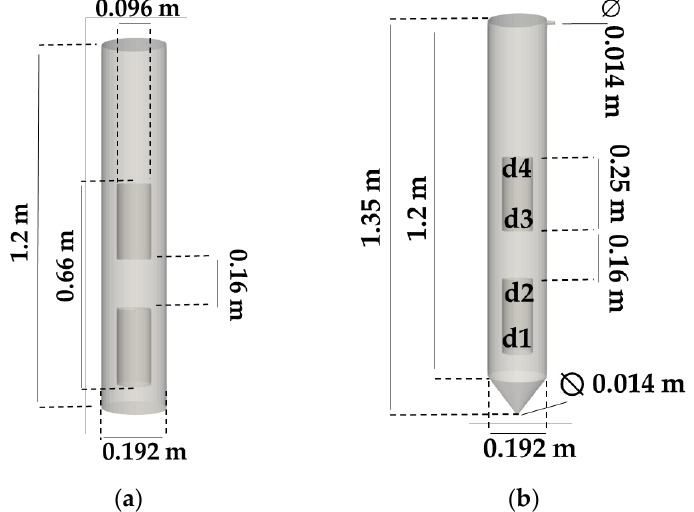
Figure 1. Multi stage air-lift reactors: ( a ) cylindrical double draft tube geometry based on Shi et al. [60] and, ( b ) coned bottom cylindrical double draft tube geometry. Table 1. Geometry internal parameters.